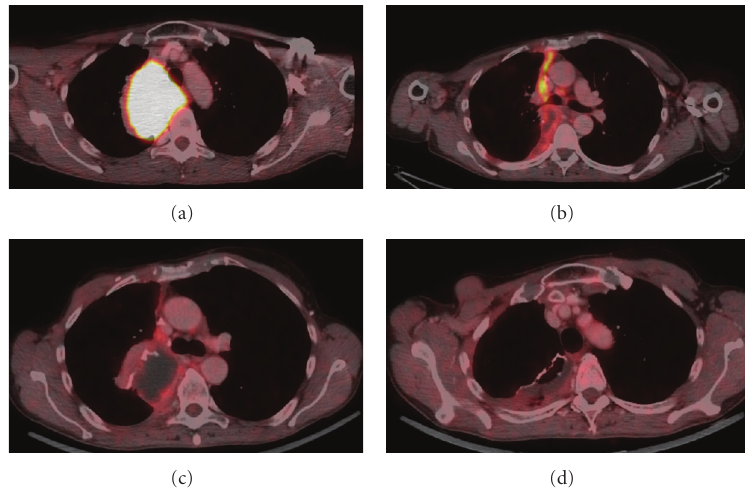
Figure 3: 18-FDG PET-CT scan with high FDG uptake in a right paramediastinal mass (a). Postoperative scans showing residual FDG uptake one month after surgery (b), a decrease in intensity after immunomodulation with intravenous immunoglobulins 4 months later (c), and sustained response at one-year followup